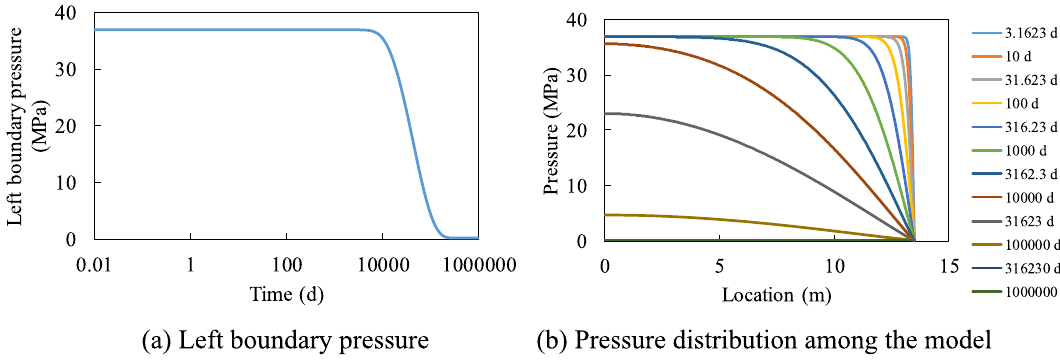
Figure 6. Change of pressure with time in the model (Longmaxi shale, L 0 = 13.5 m, P 0 = 37 MPa).